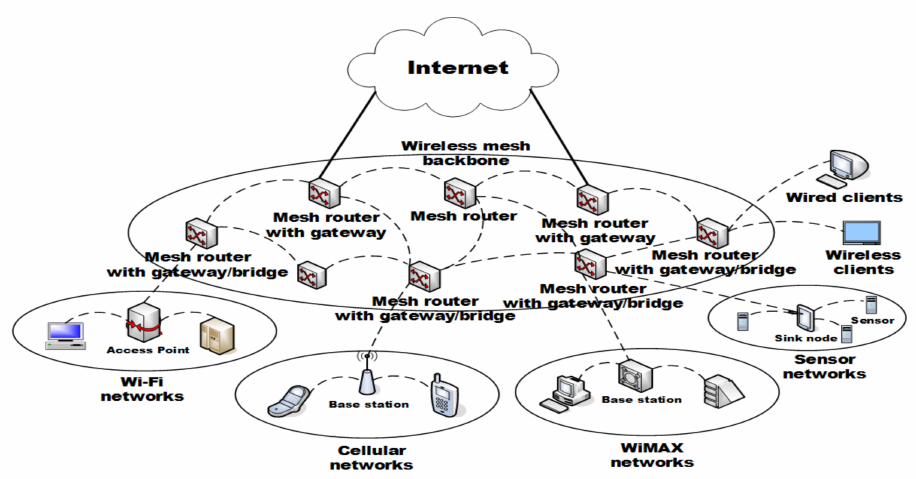
Figure 1. AIoT edge computing environments in proposed